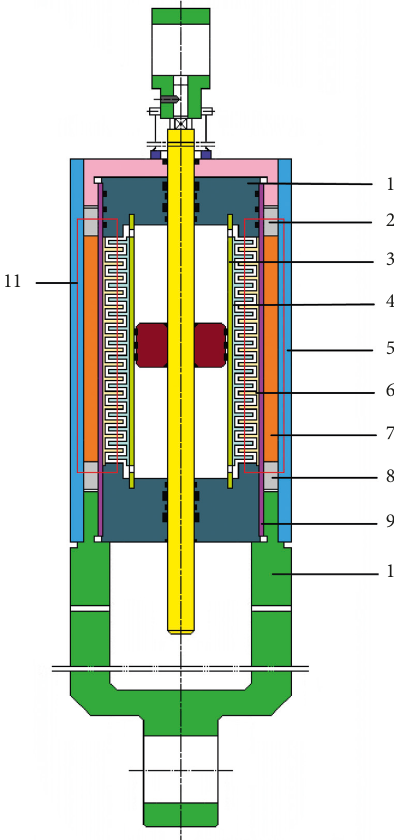
Figure 34: Schematic view of double-ended MR damper based on multistage radial flow mode:1, upper cover; 2, first magnetic ring; 3, inner cylinder; 4, inner annular baffle; 5, outer cylinder; 6, outer annular baffle; 7, coil; 8, second magnetic ring; 9, middle cylinder; 10, lower cover; 11, magnetic flux lines